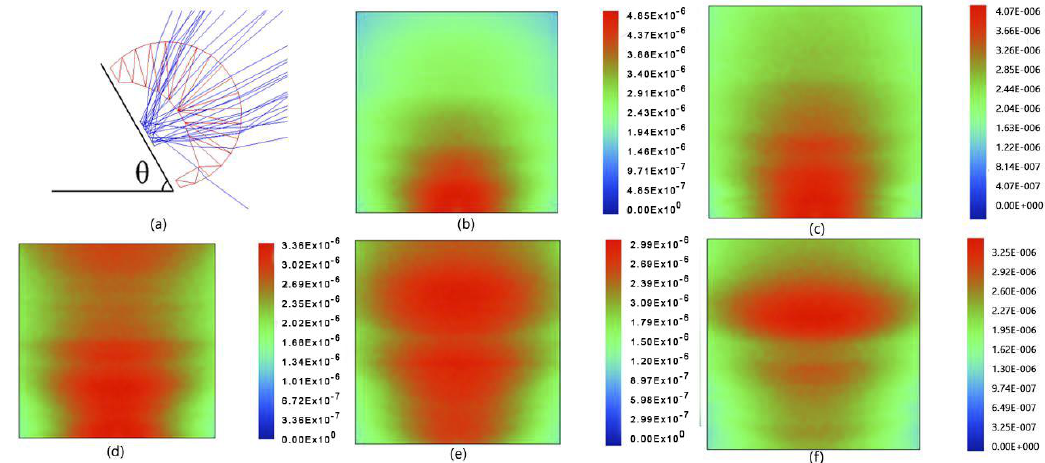
Figure 6. A close lock of the setup of simulation ( a ). Light distribution of lens B4 on the floor at the angle of ( b ) 45 ◦ ; ( c ) 50 ◦ ; ( d ) 55 ◦ ; ( e ) 60 ◦ ; ( f ) 65 ◦ , and the distance from ceiling of 40